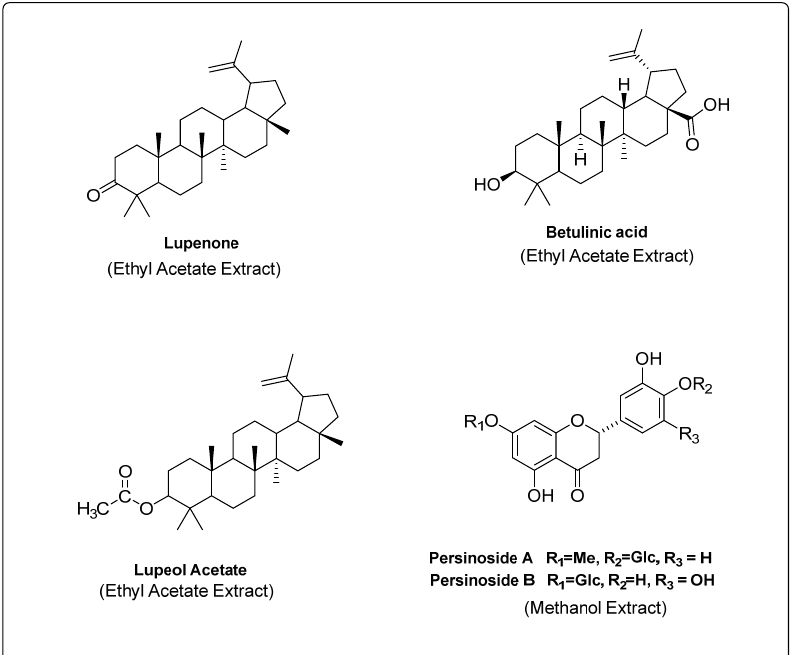
Figure 3. The major secondary metabolites identified in the hexane extracts of Anastatica hierochun ‐ tica .